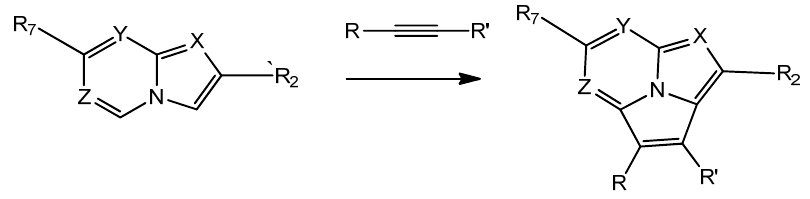
Table 14. Substituents, conditions and yields of azacyclazines from azaindolizines (Scheme 31).